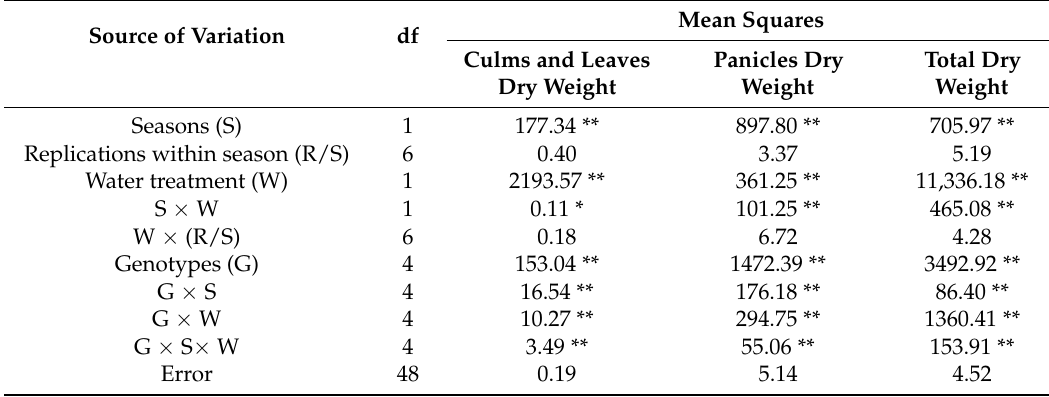
Table 3. Combined ANOVA over seasons for dry